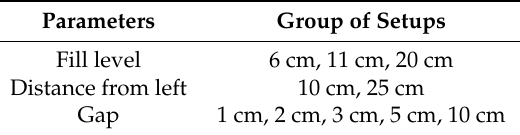
Table 1. Simulations executed in this paper.